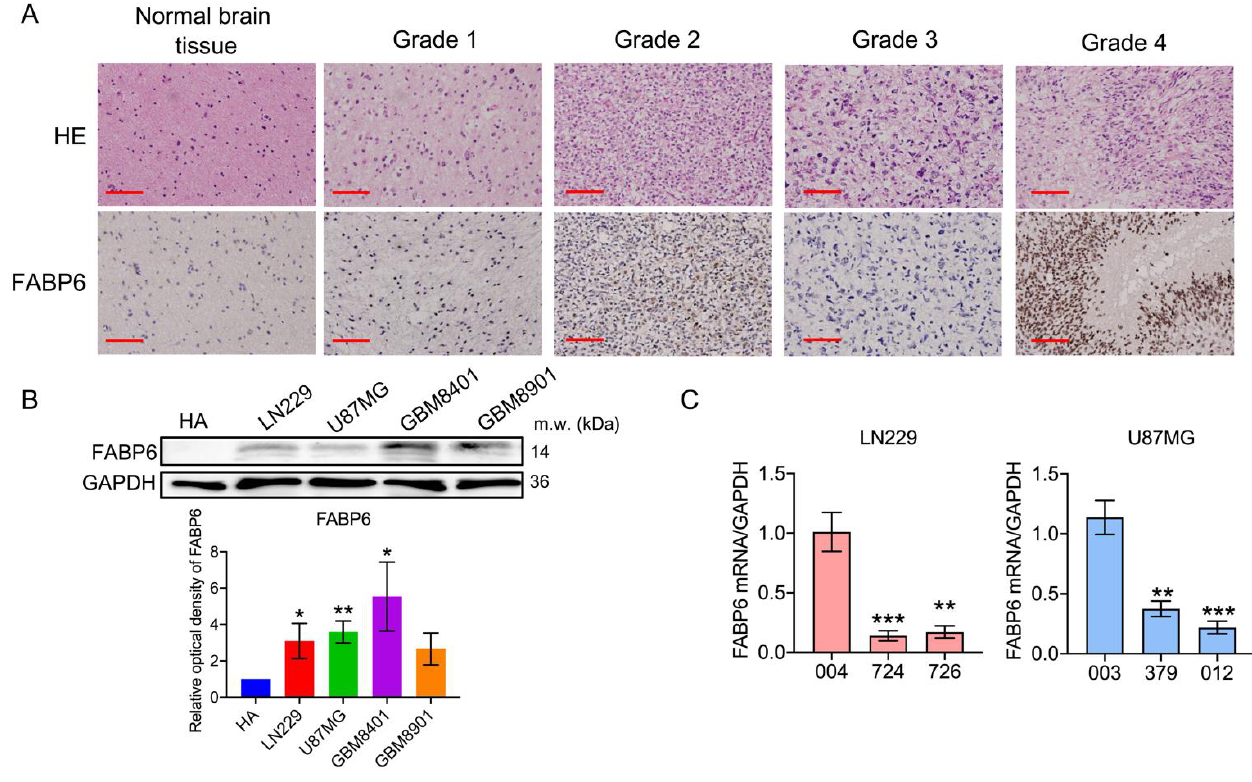
Figure 1. Fatty acid-binding protein 6 (FABP6) expression in human glioblastoma cells: ( A ) Hematoxylin and eosin (HE) staining (left column) of the normal brain tissue, pilocytic astrocytoma, diffuse astrocytoma, anaplastic astrocytoma, and glioblastoma multiforme. Immunohistological analysis of FABP6 in the right column (original magnification was ×400). Scale bar = 50 µ m. ( B ) The expression levels of FABP6 in the glioma cell lines were analyzed by Western blotting. GAPDH was used as a loading control. * p < 0.05; ** p < 0.01 compared with the human astrocytes group. ( C ) Reverse transcription- polymerase chain reaction (RT-PCR) was used to analyze the mRNA expression of FABP6 after knockdown with shFABP6. ** p < 0.01; *** p < 0.001 compared with the shScramble control group (004 in LN229 cells and 003 in U87MG cells).